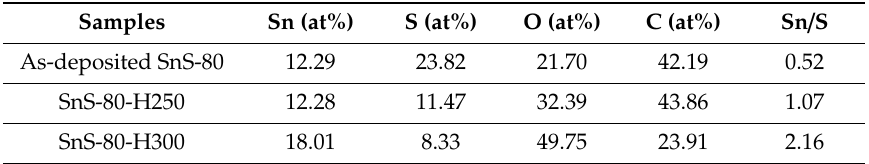
Table 1. Summaries of the atomic percentages of Sn and S and Sn/S atomic ratios in SnS-80 thin films annealed at different temperatures.